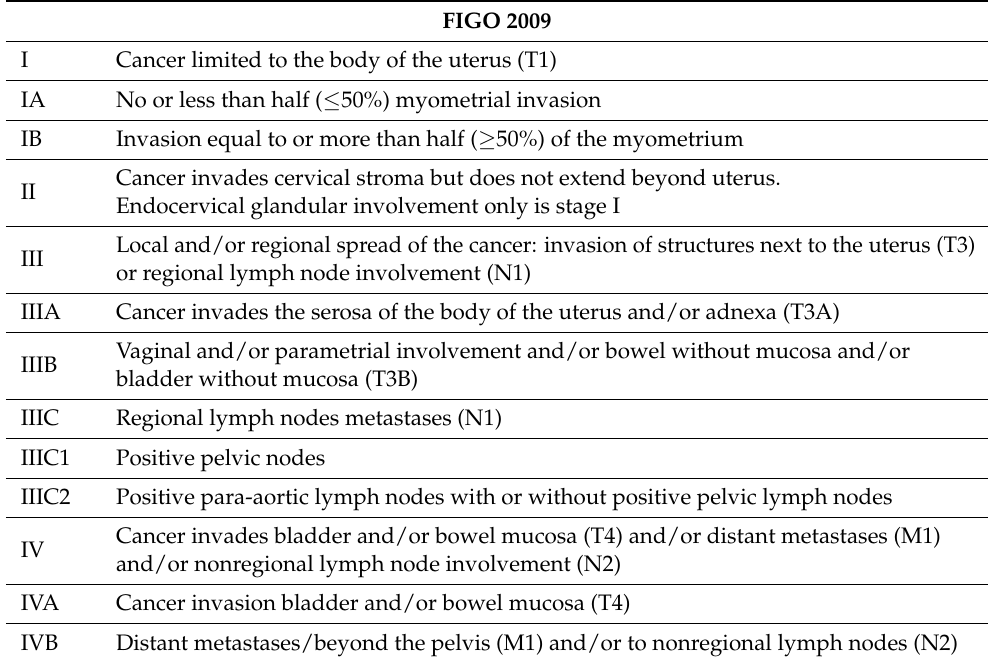
Table 5. FIGO staging for endometrial